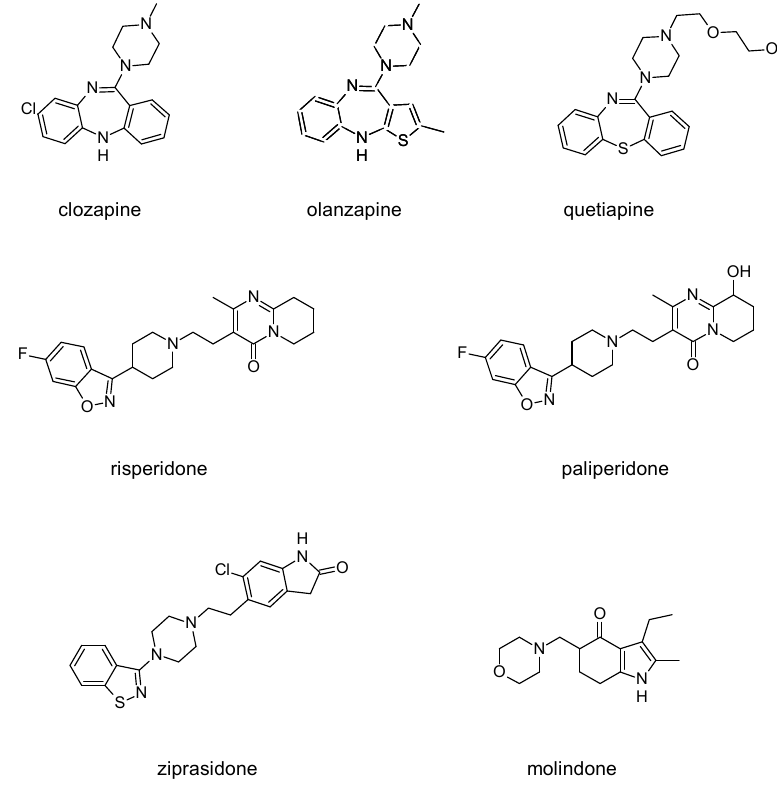
Figure 1. The chemical structures of representatives of second-generation antipsychotic drugs. Clozapine, as an atypical antipsychotic, is dopamine and serotonin receptor antagonist. It binds to dopamine D 1–5 receptors, with ten times higher affinity to D 4 receptors than to D 2 . Both D 4 and 5-HT 2A antagonist properties contributes to decrease of negative symptoms and lower occurrence of extrapyramidal side effects. The effect of clozapine on 5-HT 2A receptor signaling differs from classic GPCR antagonists, as it also induces 5-HT 2A receptor internalization and activates Akt signaling via a 5-HT 2A receptor-mediated event [112]. Thus, clozapine may also be considered a functionally